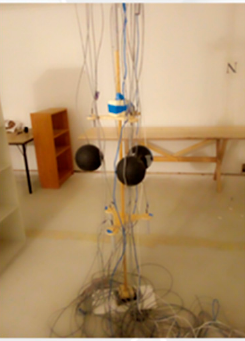
Figure 8. Environmental control equipment. Table 1. Summary of sensors and other